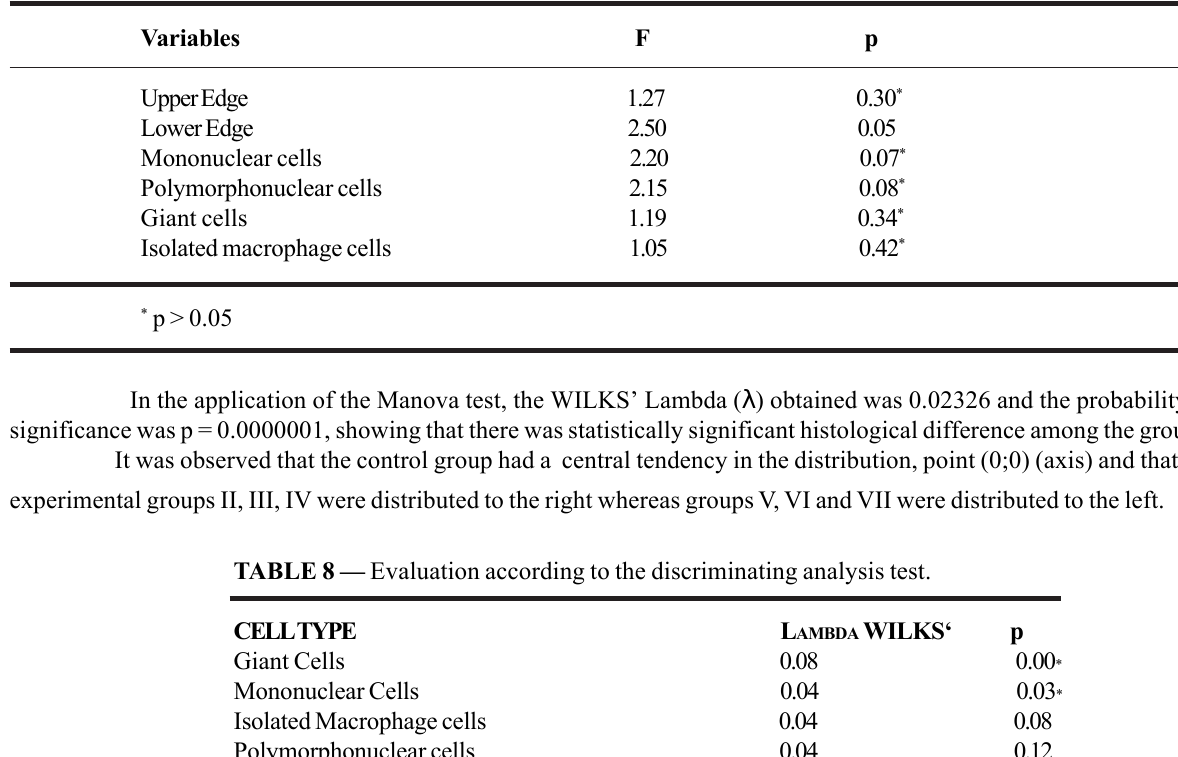
TABLE 7 — Analysis of the LEVENE variance homogeneity test of all variables.